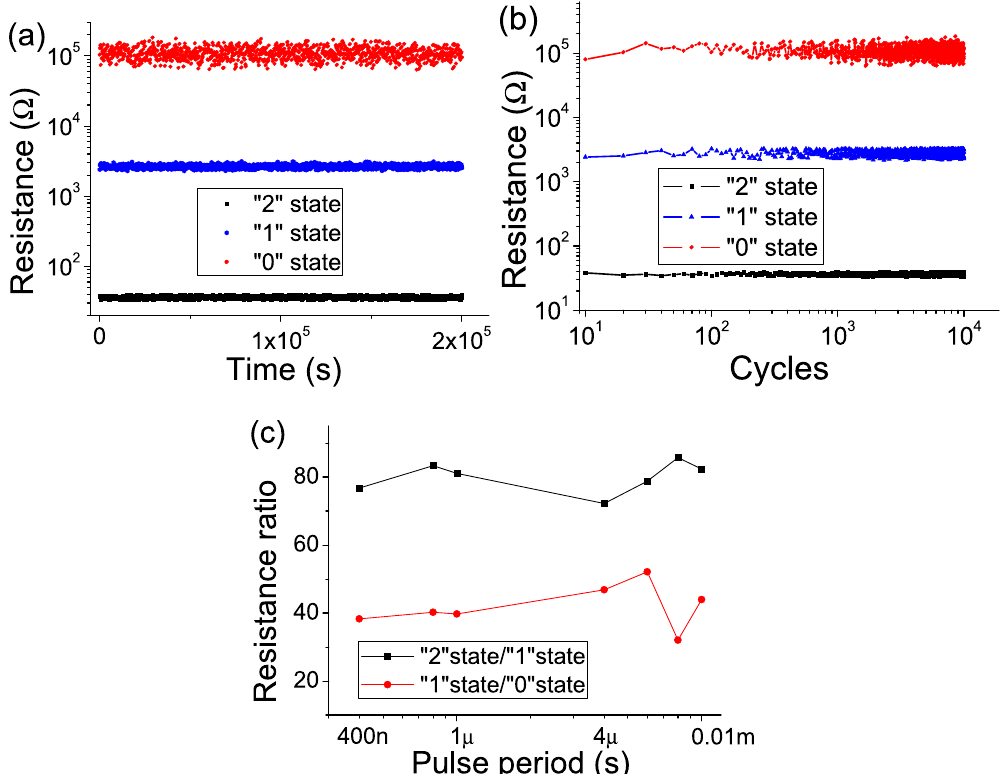
Figure 6. ( a ) Retention test of the ITO/PS + GO/Al device at reading voltage of 1 V. ( b ) Endurance performance of the ITO/PS + GO/Al device in the pulse switching mode. ( c ) Dependence of resistance ratio on pulse period in ITO/PS + GO/Al device.